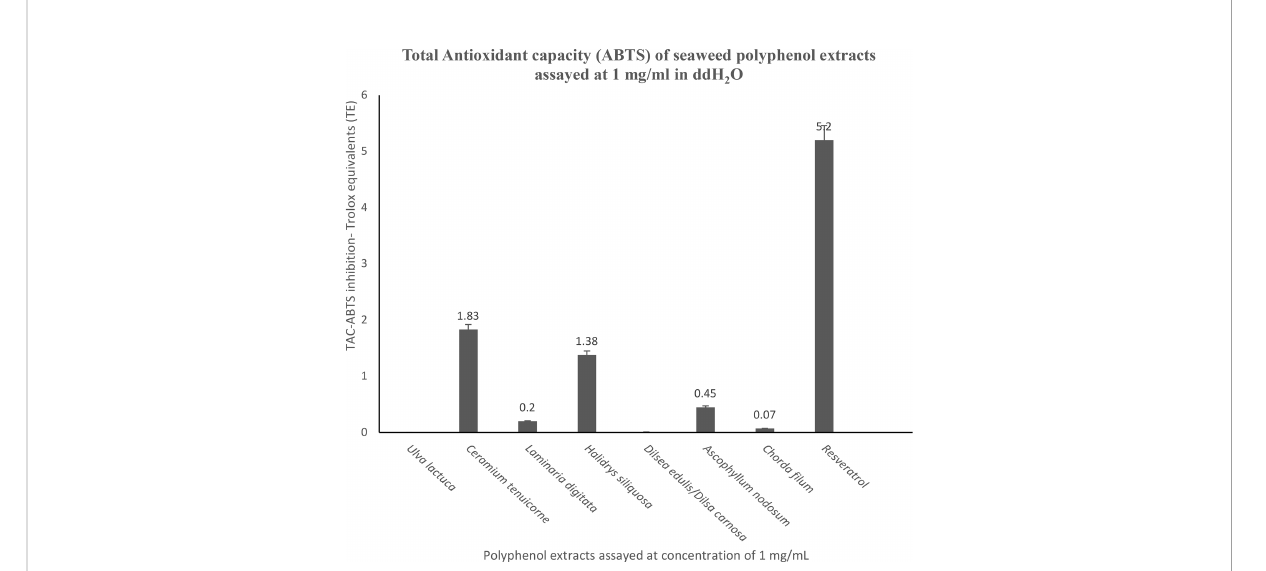
FIGURE 2 Total antioxidant capacity by 2, 2 ′ -azino-bis (3-ethylbenzothiazoline-6-sulphonic acid) (ABTS) inhibition by seaweed polyphenol extracts. All of the samples and the positive control resveratrol were tested at a concentration of 1 mg/mL and the results are expressed in mM Trolox equivalents.